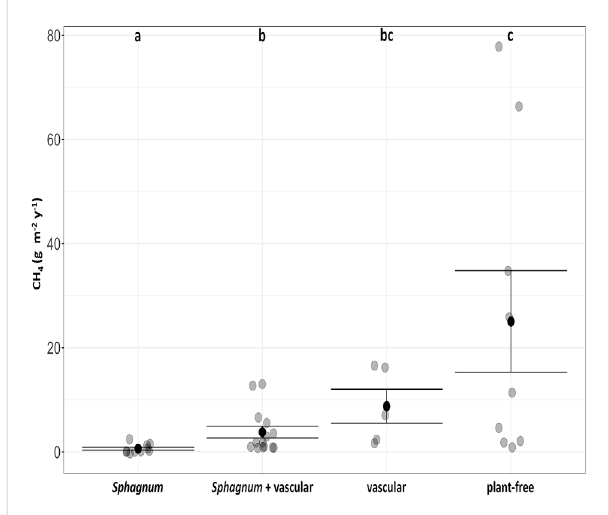
FIGURE 3 CH 4 emission factors in the 4-type classi fi cation scheme of ditches of boreal forestry-drained peatlands. Shown are average ± SE (inblack) calculatedfromthereplicateobservations(ingrey).Different letter (top-part of the fi gure) denote signi fi cant pairwise differences between groups (1-ANOVA, F (3, 33) = 10.53, p < 0.001; Pairwise t -test with Holm-Bonferroni adjustment of the p -value, p <